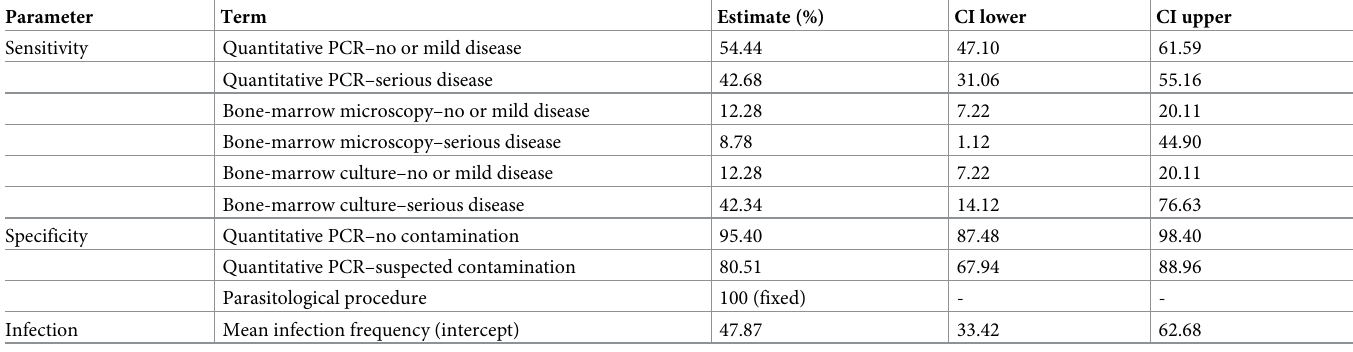
dog infection did not perform any better than model {36} itself; AICc scores were from 1.93 to 4.05 units larger (S1 Table). Two-level covariate models estimated near-zero effects for appar- ently healthy ( − 0.144, SE 0.353) and seriously diseased dogs (0.049, SE 0.598). A final alterna- tive version of model {36} with a three-level clinical-condition covariate on infection also estimated near-zero effects for mildly-diseased (0.145, SE 0.362) and seriously-diseased dogs